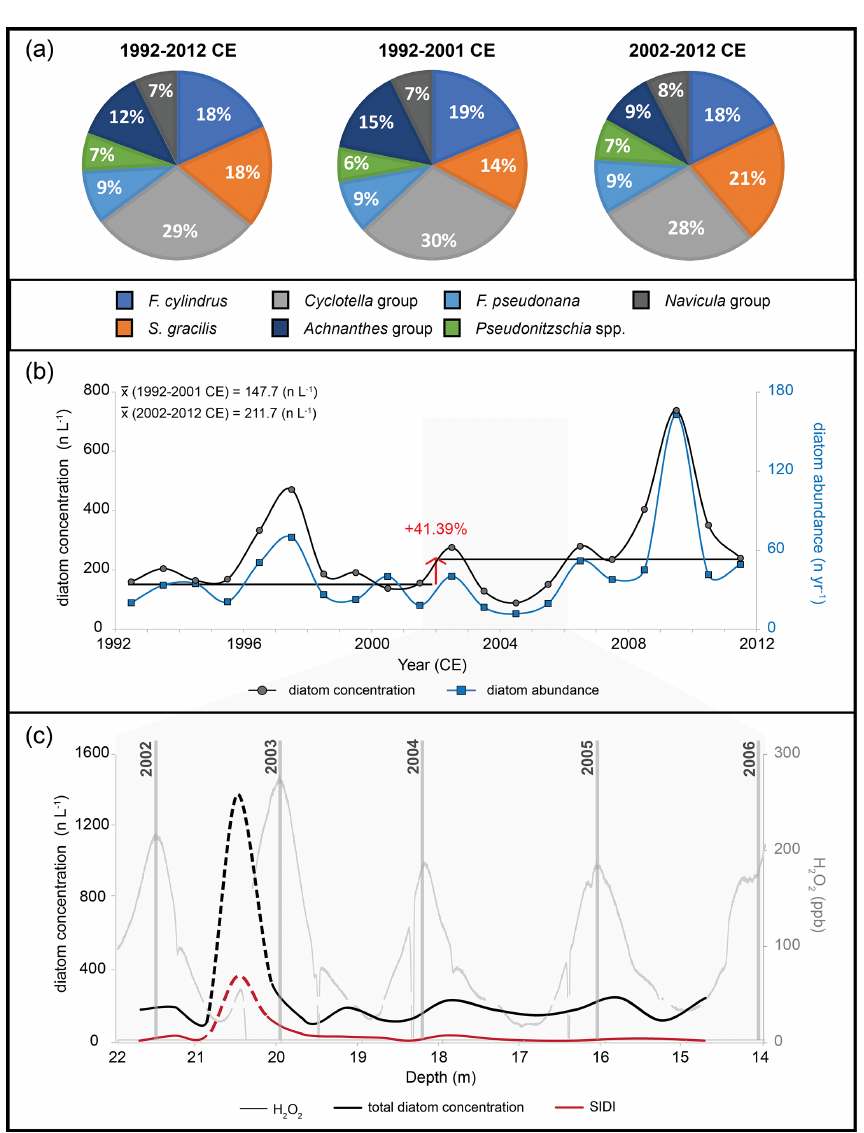
Figure 2. Diatom record from the JUR ice core. (a) Main diatom assemblage composition of the JUR ice core during 1992–2012CE and during decadal subsets. Percentages reported in this figure were normalized to the main species identified. (b) Diatom concentration and diatom abundance time series. The red arrow represents the percentual variation in the diatom concentration decadal mean. (c) Total diatom concentration and SIDI variations down-core for the 2002–2006CE horizon. Vertical grey lines indicate temporal horizons based on the austral summer maxima in H 2 O 2